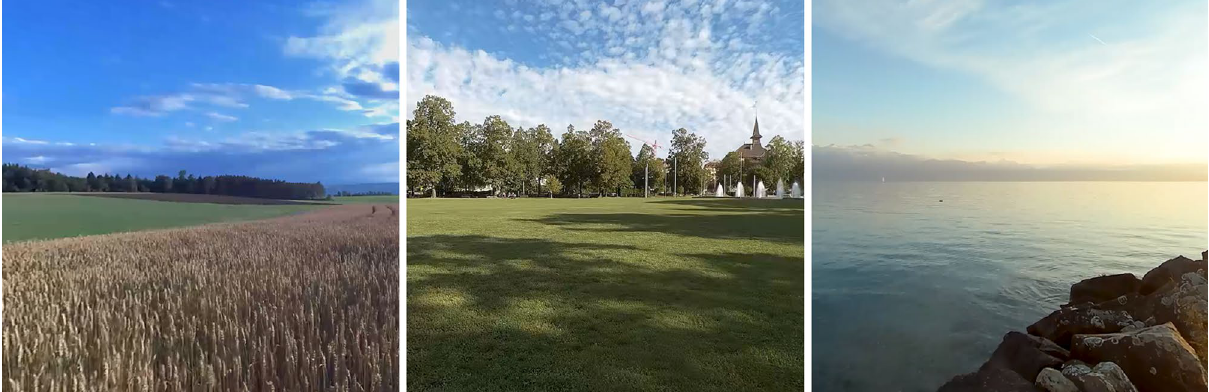
Figure 1. Still photo from three of the videos provided to the participants via the head-mounted